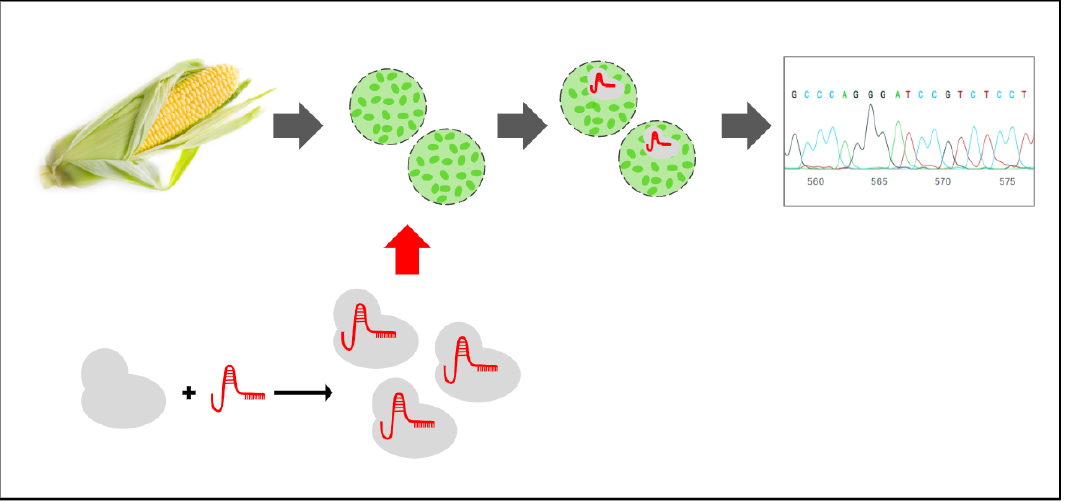
Figure 1. Methodological approach of the present study. Maize seeds were germinated in vitro ; the second leaves of the seedlings were used to obtain the protoplasts. The protoplasts were exposed to the CRISPR-Cas9 ribonucleoproteins complex (RNP), and after 24 h, the DNA was extracted from the samples. PCR fragments were amplified and sequenced. Maize image was taken from the free repository from pexel.com.